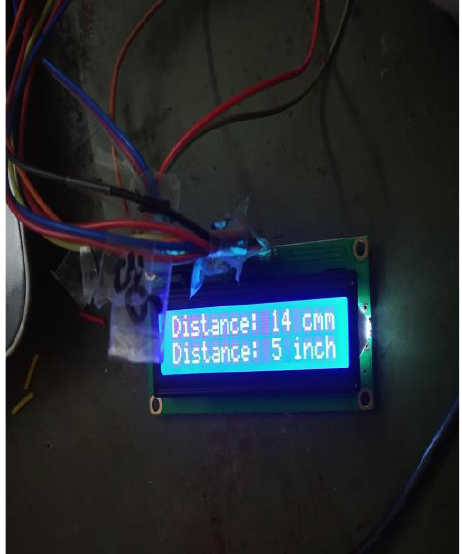
Figure 14. Distance measuring sensor placed on the inner lid of smart bin.